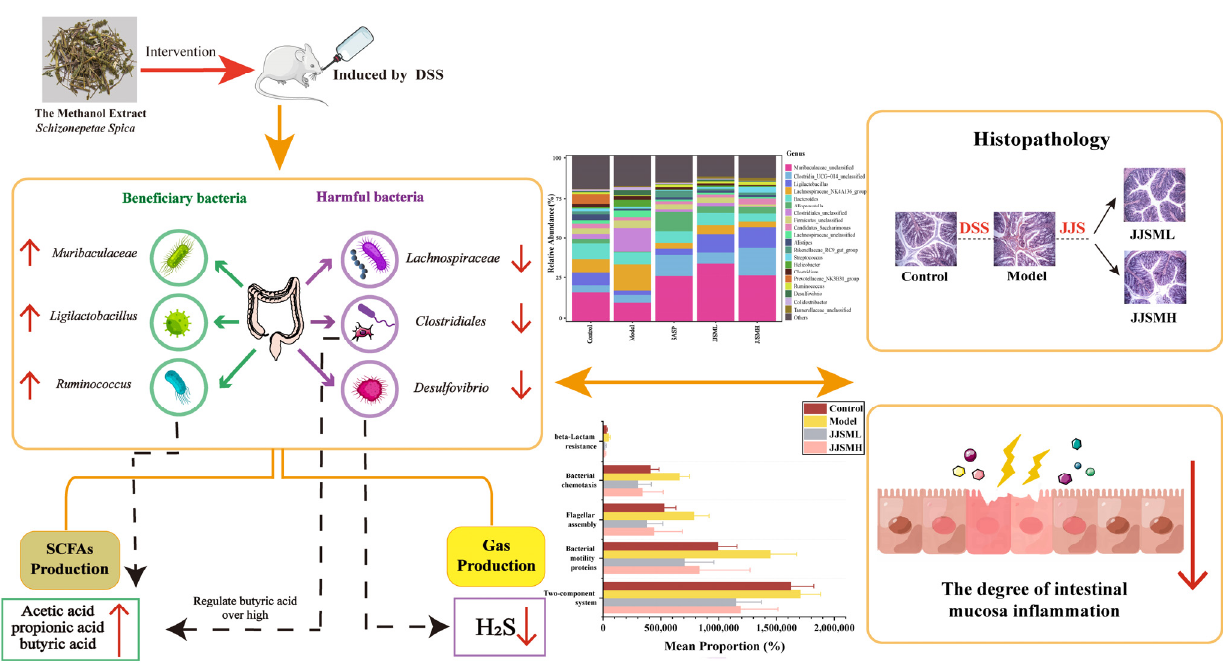
Figure 6. Schematic diagram of JJSM relieving colitis.